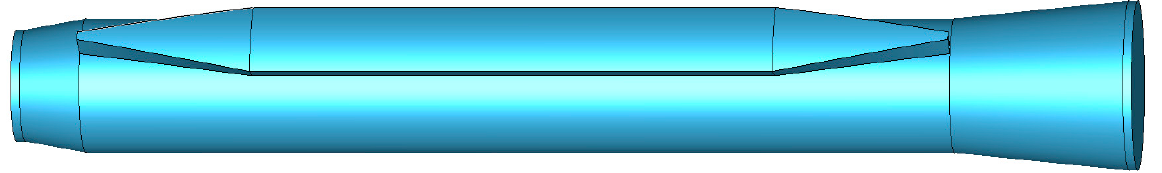
Figure 17. Schematic of a gyrotron cavity with an azimuthal groove.